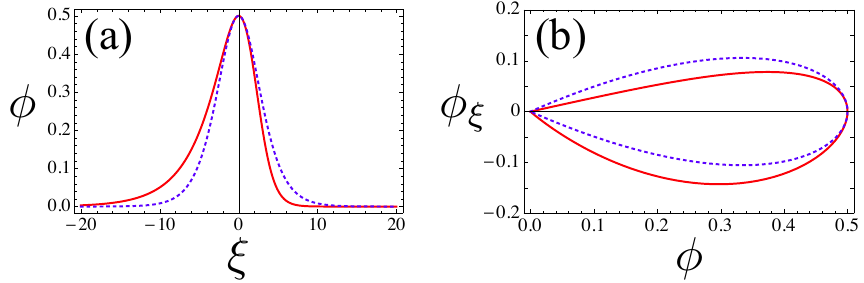
Fig. 2 Bright solitary waves for β = 0 . 3, φ 0 = 0 . 5 and c = 2 . 5. (a) Profiles from Eq. (45) (solid curve) and the explicit solution given by Eq. (46) (dashed curve). (b) Homoclinic orbits from Eq. (45) (solid curve) and Eq. (46) (dashed